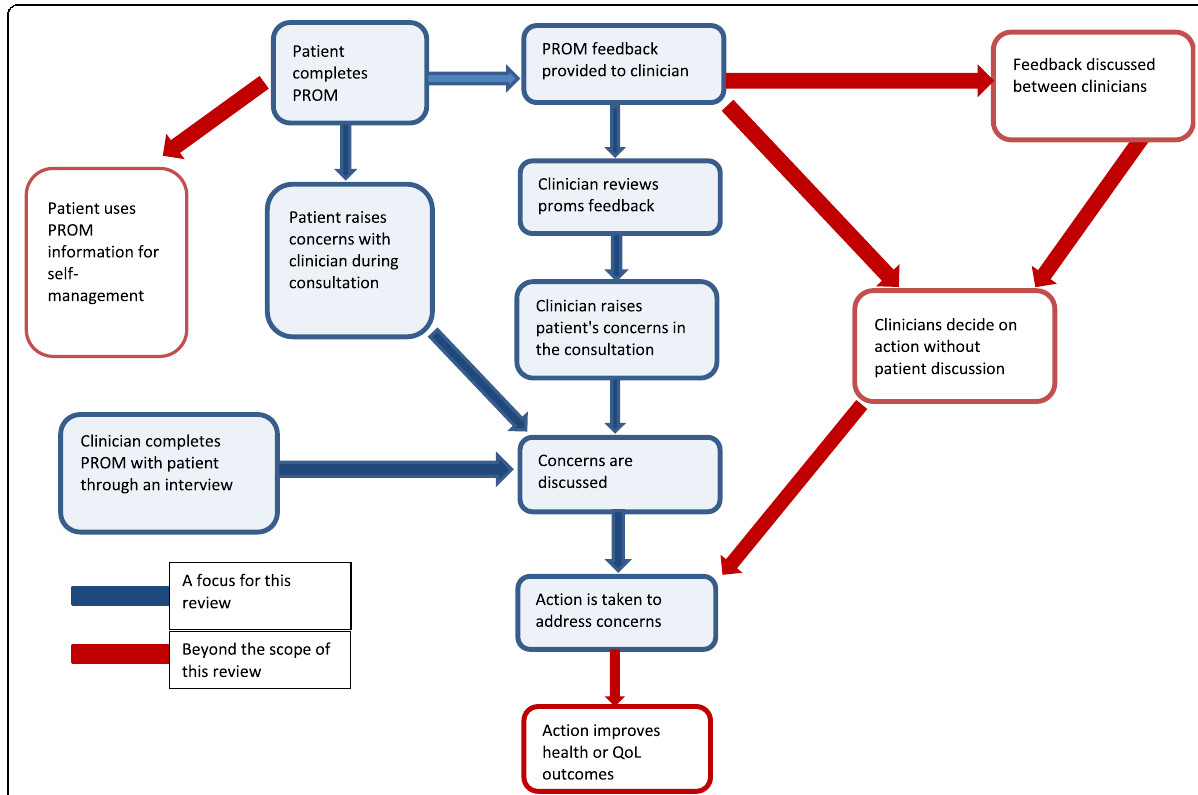
Fig. 4 PROMs feedback in the care of individual patients: Implementation chain at start of